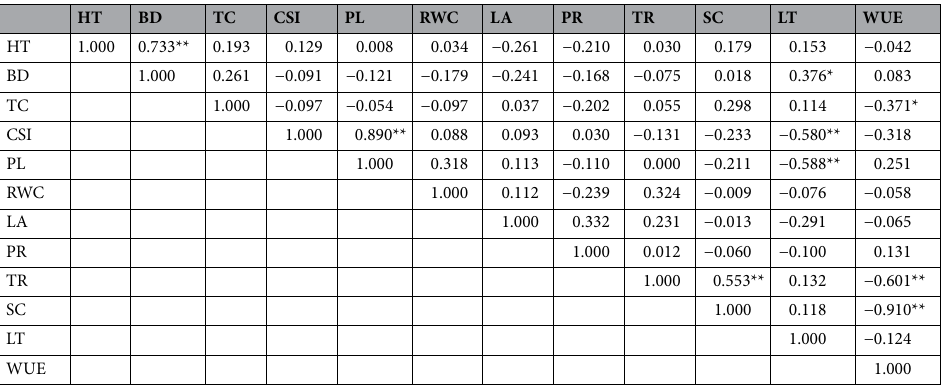
Table 6. Correlation analysis among growth traits, biochemical parameters, physiological parameters and ecophysiological traits of teak seed sources. **Indicate highly significant difference at p < 0.01 level of probability. *Significant difference at p < 0.05 level of probability. HT—Height, BD—Basal Diameter, TC— Total Chlorophyll, CSI—Chlorophyll Stability Index, PL—Proline Content, RWC—Relative Water Content, LA—Leaf Area, PR—Net Photosynthetic Rate, TR—Transpiration Rate, SC—Stomatal Conductance, LT—Leaf Temperature and WUE—Intrinsic Water Use